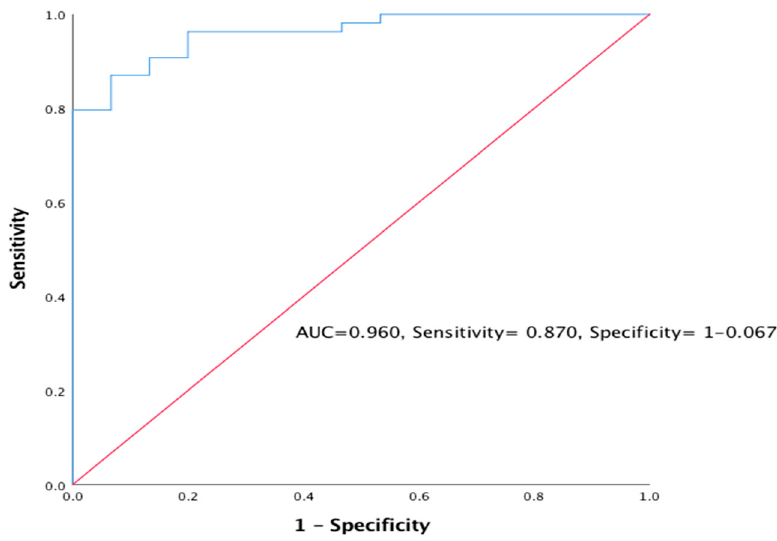
Figure 2. Receiver operating characteristics (ROC) curve was used to validate predictors of primary outcome using eGFR (CKD ≥ 3). Table 7. Multivariate logistic regression for the prognostic outcome of primary MGN using UPCr Index (Remission). Variable B SE AOR 95% C.I. p -Value Creatinine